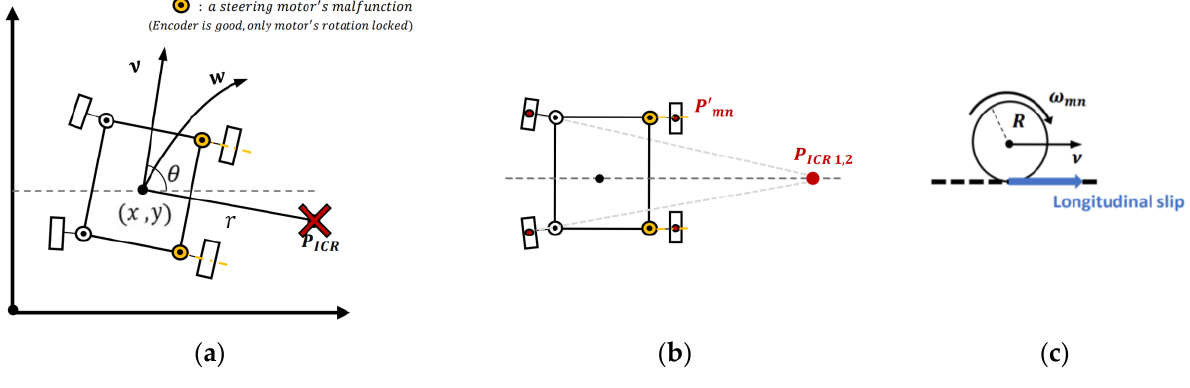
Figure 6. Illustrations of 2D kinematic analysis when the right steering motor malfunctions. ( a ) Pose of the robot on a 2D Cartesian coordinate system. ( b ) ICR of each wheel under the lateral slip condition. ( c ) Side view under the longitudinal slip condition.